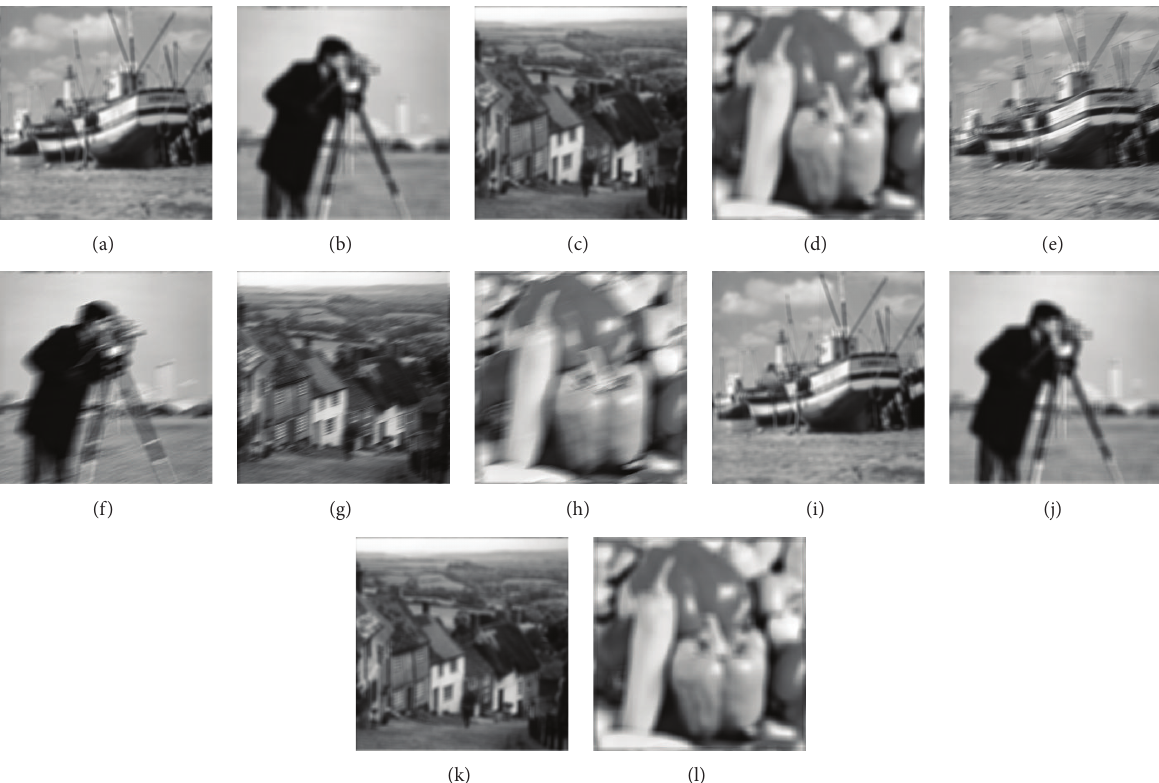
Figure 2: Blurred-noisy images. ((a) to (d)) Gaussian blurred-noisy images with BSNR = 40 dB; ((e) to (h)) motion blurred-noisy images with BSNR = 40dB; ((i) to (l)) average blurred-noisy images with BSNR = 40 dB.